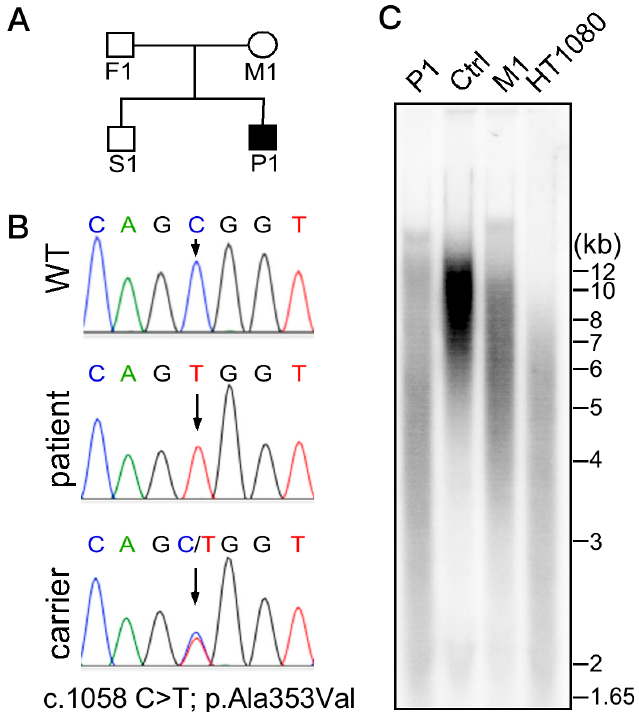
Figure 1. ( A ) Pedigree of the affected family. Solid symbol represents the affected patient and open symbols represent unaffected relatives. Squares indicate males and circle indicates a female subject. ( B ) Sanger DNA sequencing of DKC1 exon 11 on chromosome X from peripheral blood cells taken from subjects of the studied pedigree. Wild-type (S1), patient (P1), carrier (M1). ( C ) Telomere length analysis (by terminal restriction fragment assay) of DNA from leukocytes of the patient (P1), an age-matched control (Ctrl), a carrier (M1), and from HT1080 fibrosarcoma cancer cells. The patient (P1) had exceedingly shortened and heterogeneous telomeres compared to the control (Ctrl).